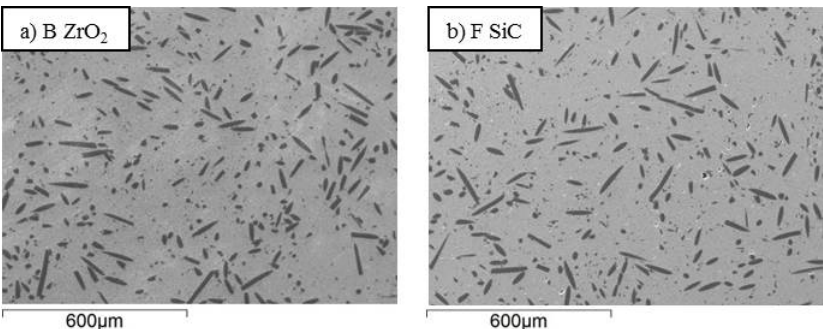
Figure 4. ( a ), ( b ) SEM-images of samples milled with different milling media, see labels. The polished sections were cut perpendicularly to the hot pressing direction.